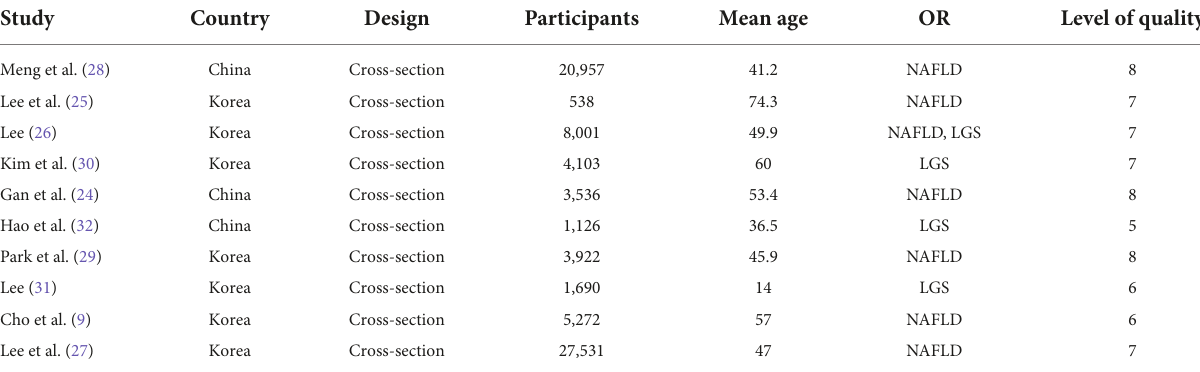
TABLE 1 Baseline characteristics of studies included